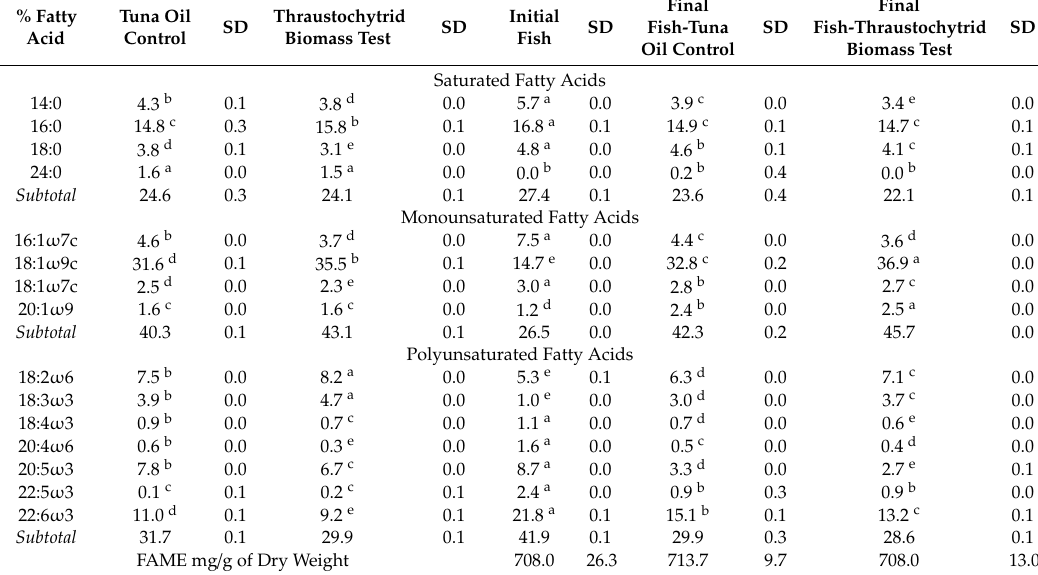
Table 3. Fatty acid (FA) composition (expressed as % of total FA) of diets, the initial fish and the final fish; fatty acid methyl esters (FAME as mg / g of dry weight) for the initial and final fish. % Fatty